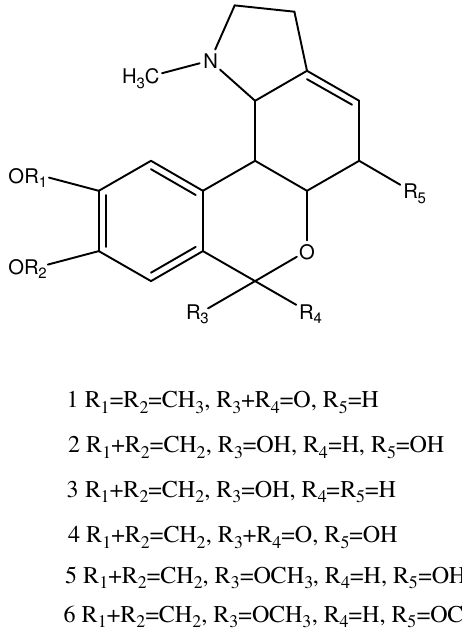
Figure 4. Structure of compounds in L. aurea